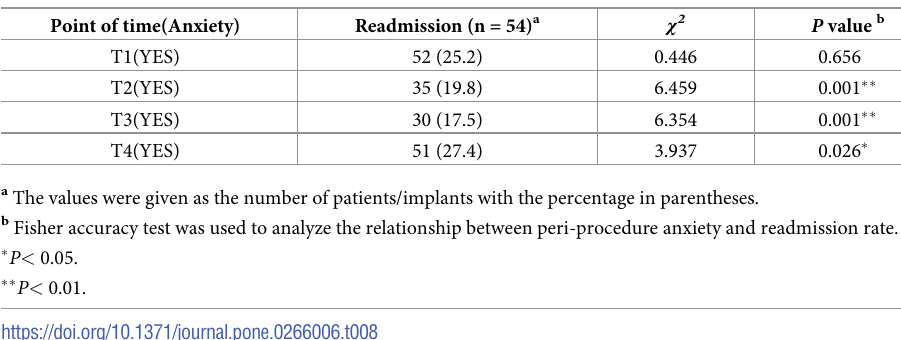
Table 8. The relationship between peri-procedure anxiety and readmission.